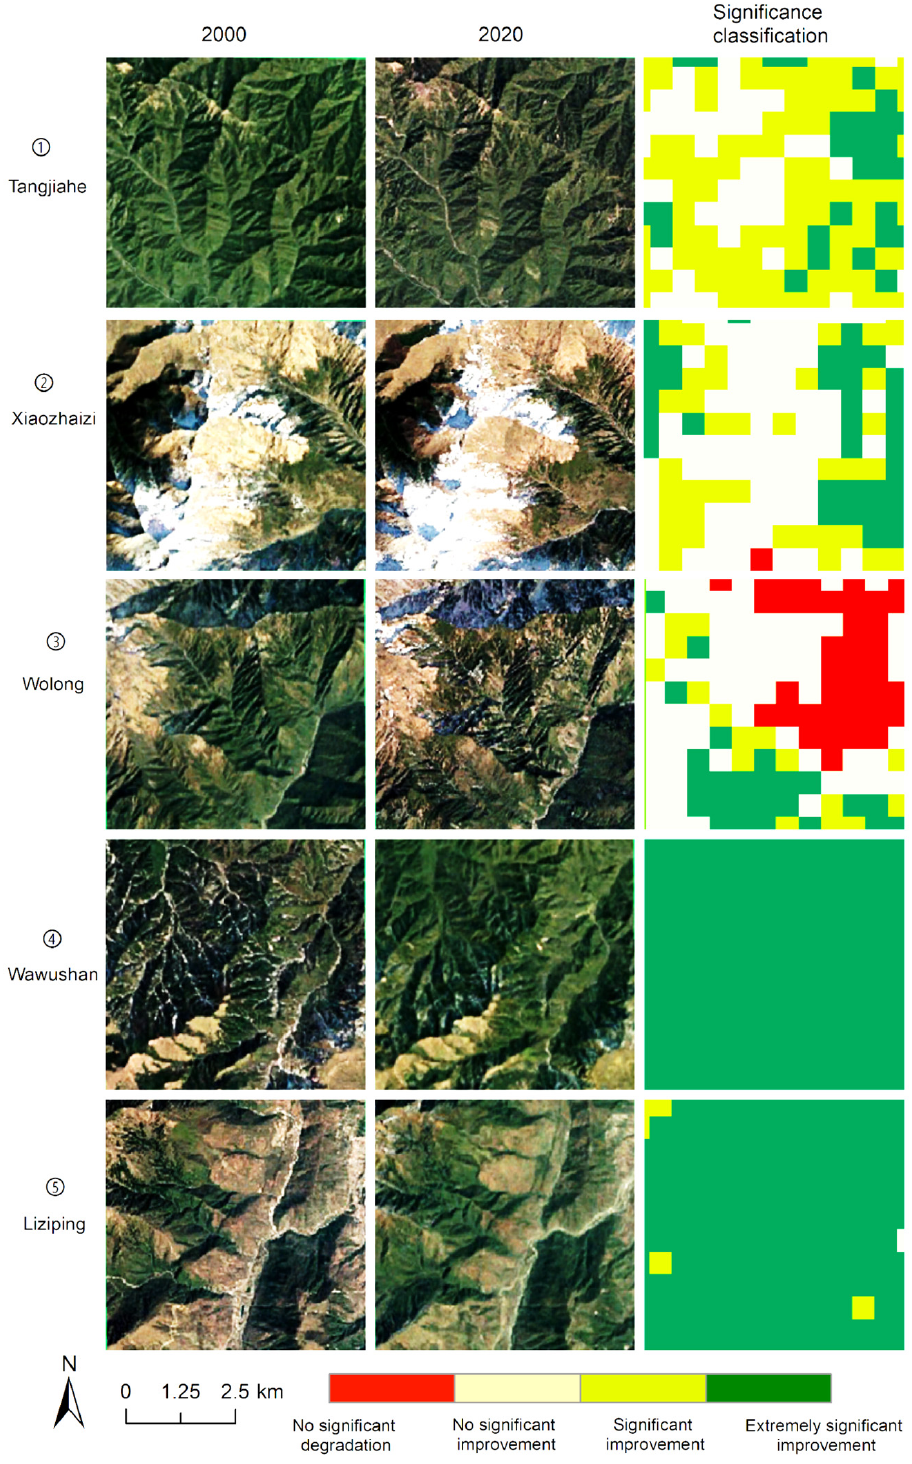
Figure A2. Remote sensing image of verification area. Table A1. Statistics of driving factors in different geomorphological zones.